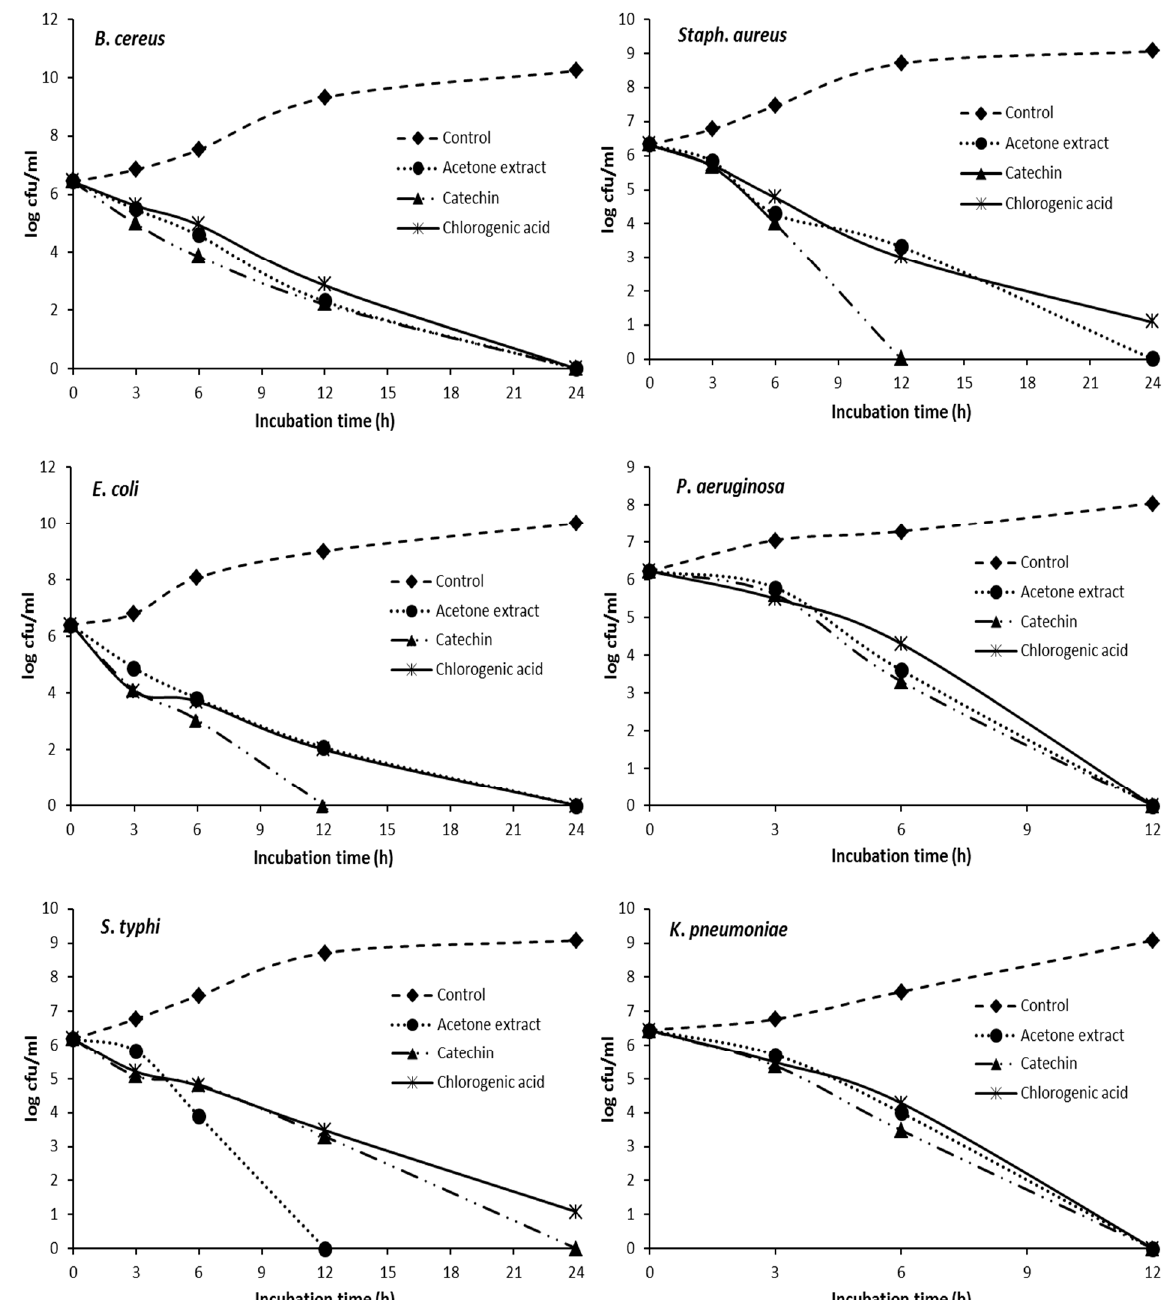
Figure 2. Time-kill data for a synergistic combination of tetracycline with acetone fraction, catechin, and chlorogenic acid against B. cereus , Staph. aureus , E. coli , P. aeruginosa , S. typhi, and K. pneumoniae